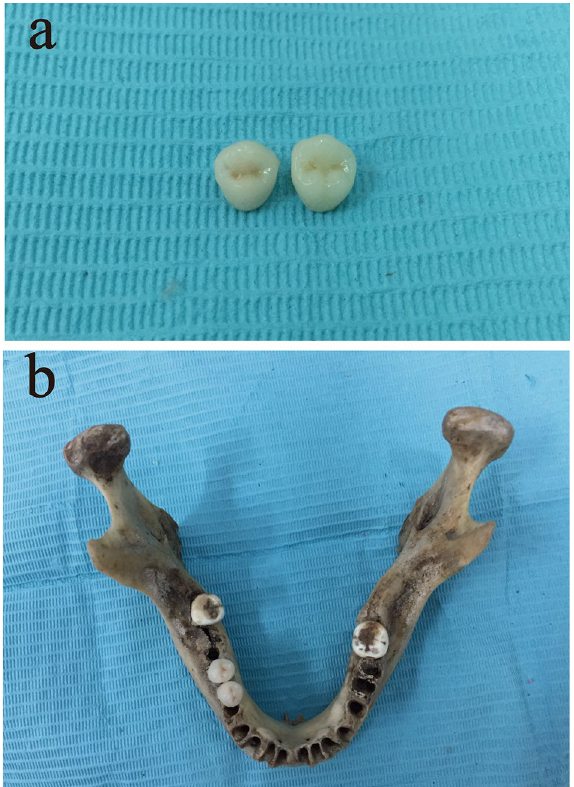
Figure 1. Zirconia crowns of premolars after fabrication ( a ) and a dry human mandible after implant insertion and zirconia crown restoration ( b ).